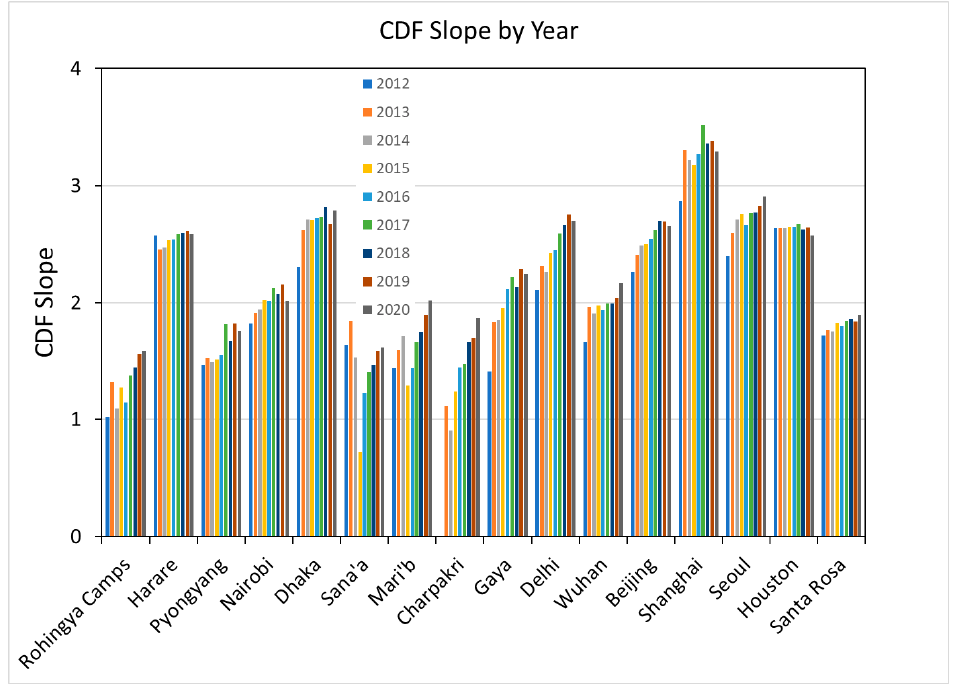
Figure 29. Picket-fence chart of the mean CDF slope for each of the test sites by year.